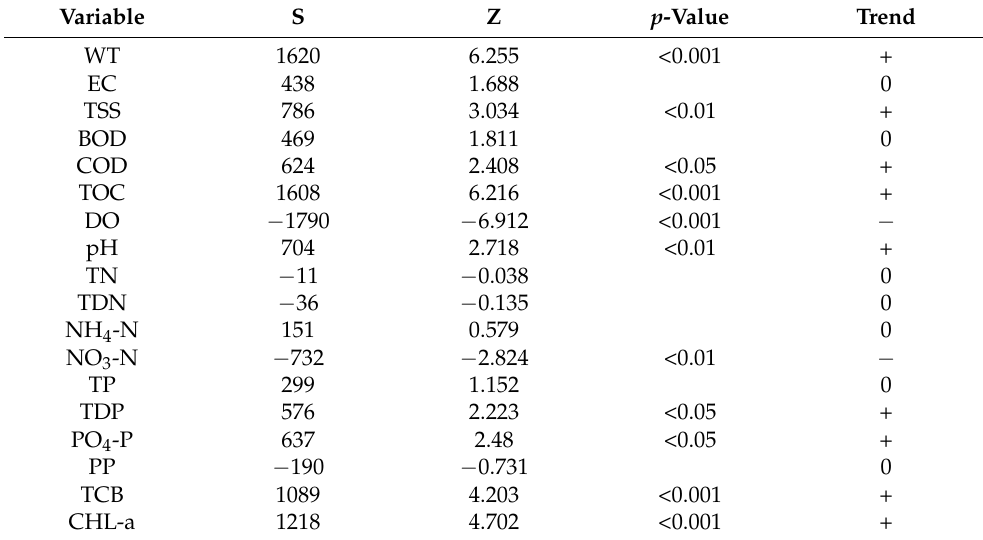
Table 3. Long-term trend analysis of limnological variables in the reservoir over the period 2013–2019 (S–Statistic, Z–Standardized variable, (+)–significantly upward trend, (0)–no trend, ( − )–significantly downward trend, PP–particulate phosphate, TCB–total coliform